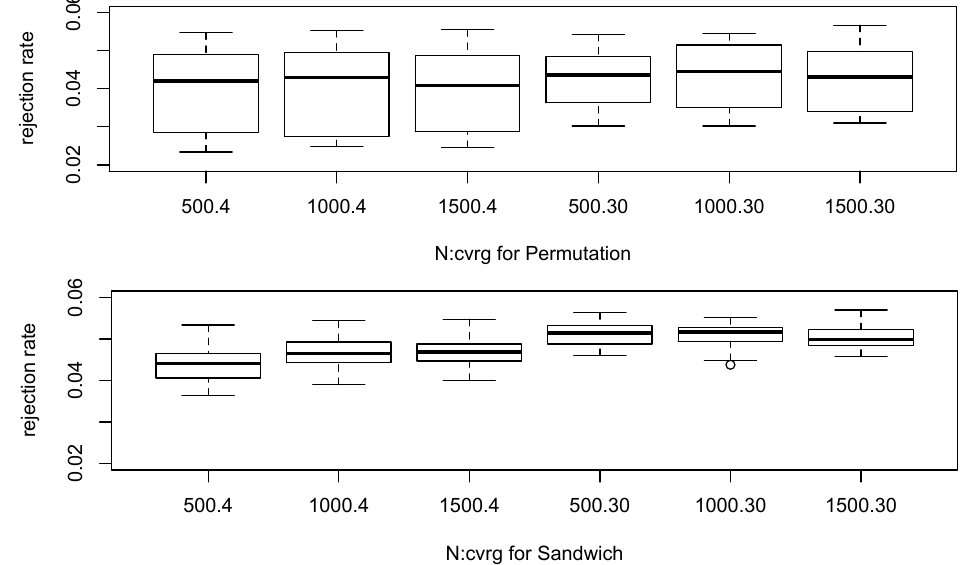
Figure 1. Boxplot of the empirical rejection rates under the null hypothesis.